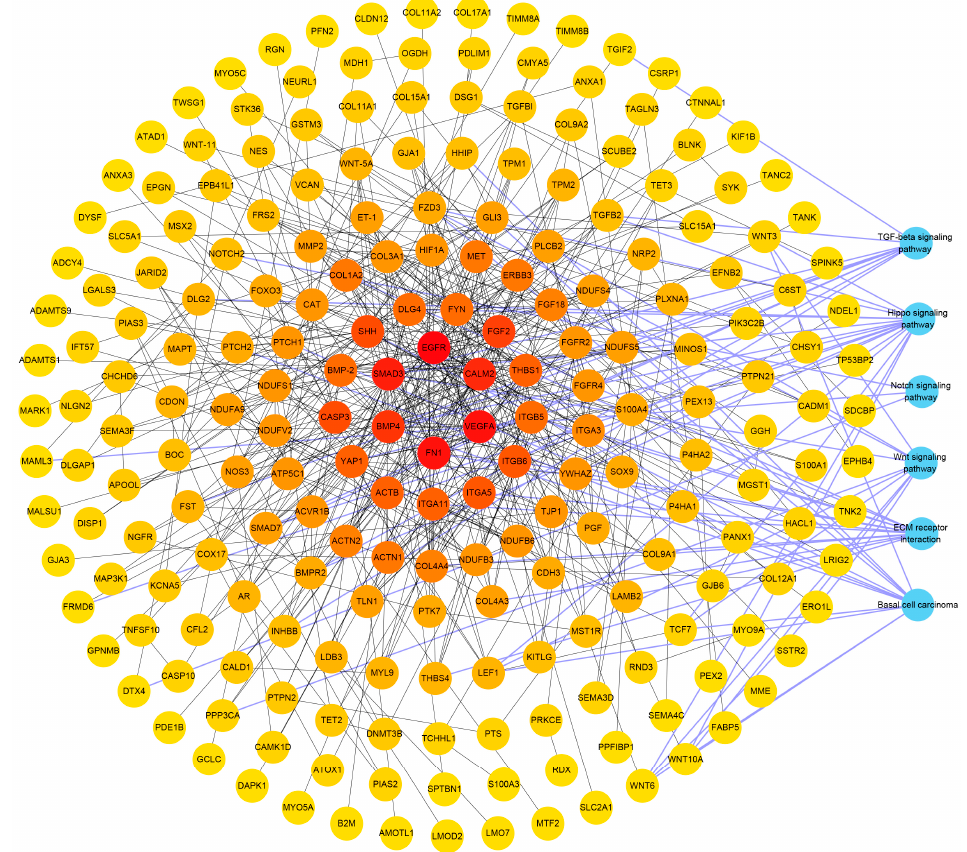
Figure 6. PPI analysis for DEGs in hair follicles between the coarse and fine wool groups. Each node means a gene, and each edge means the interaction between genes. The blue nodes mean the signaling pathways enriched by DEGs. A darker color indicates a stronger interaction with more genes.